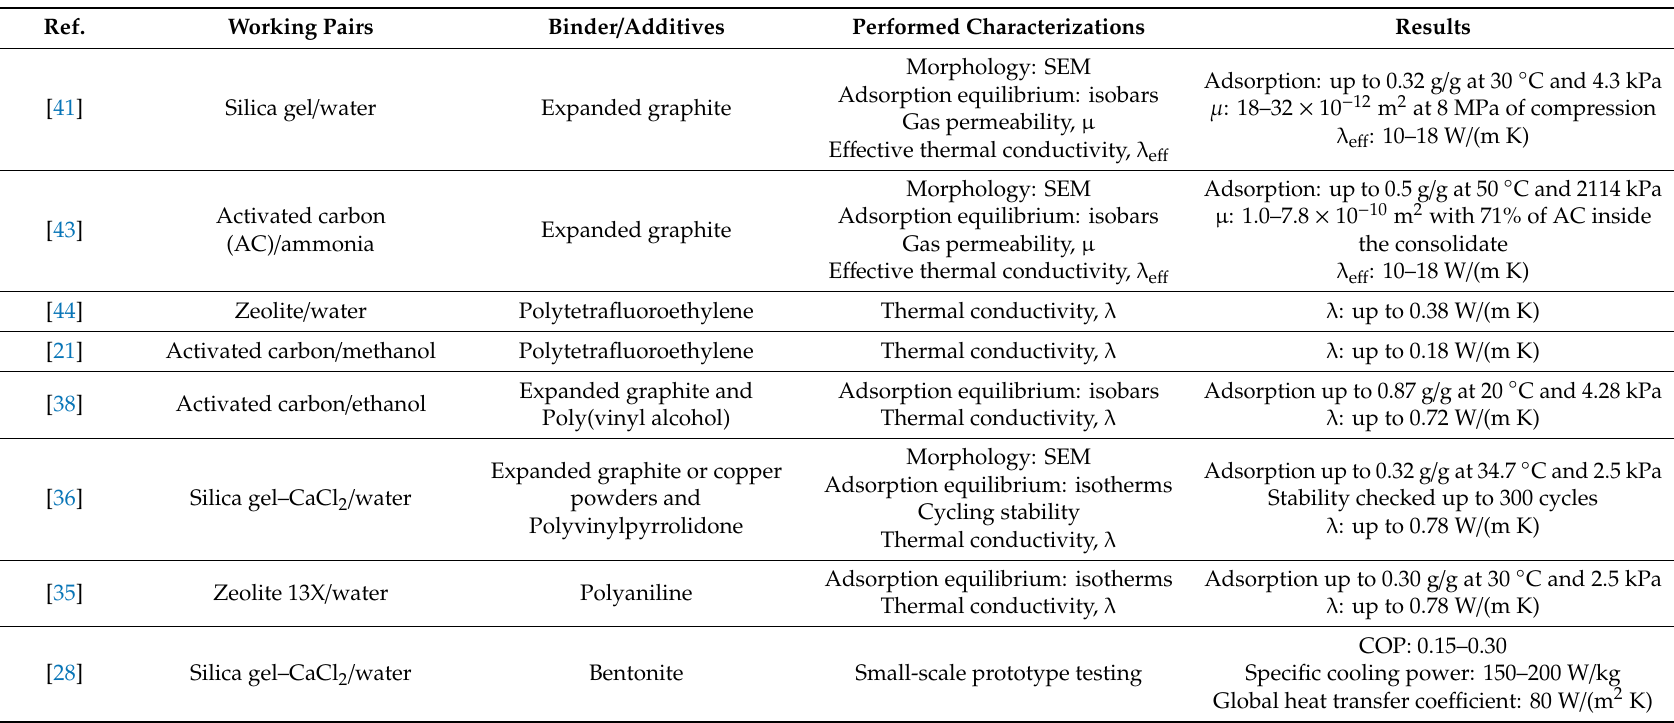
Table 1. Main features of the developed consolidated bed technology for heat pump applications.